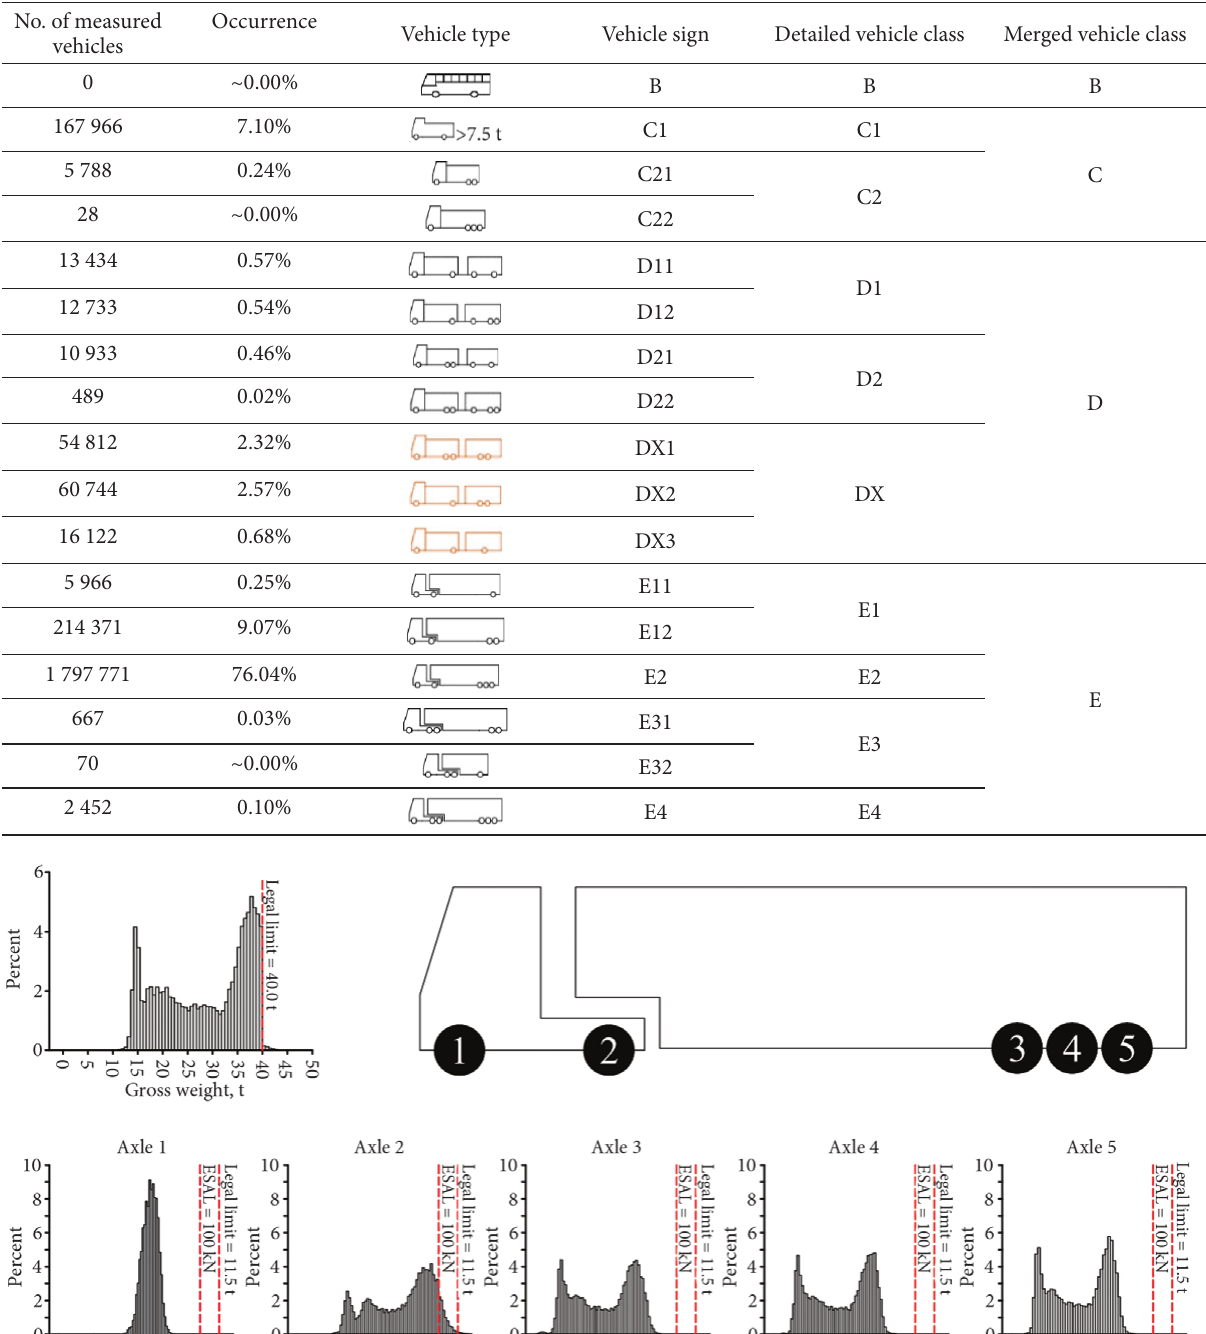
Table 2. Distribution of measurements